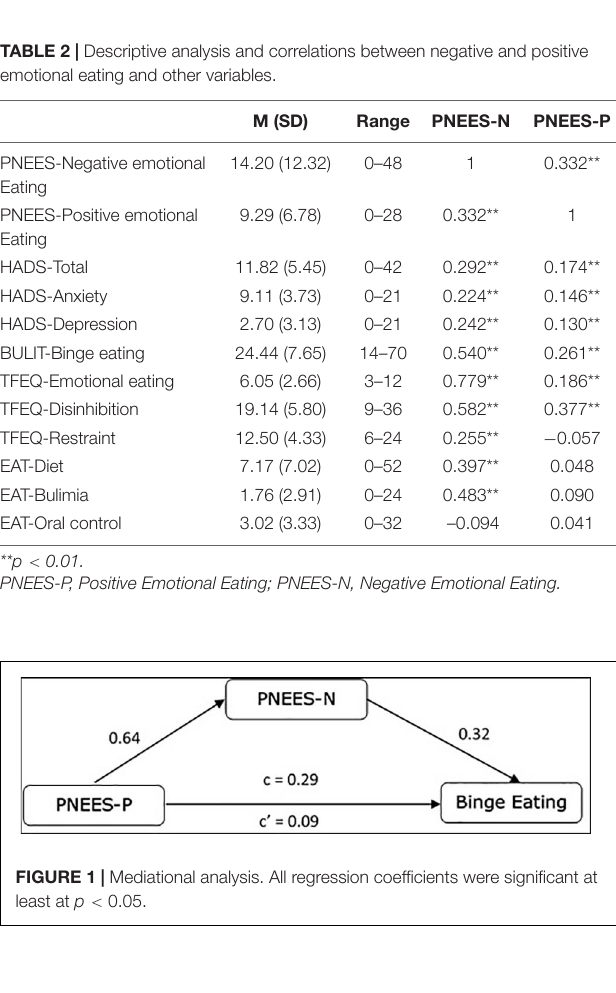
of Spanish population. Currently, there is no other translated version of the original PNEES. The results showed that the adaptation process was